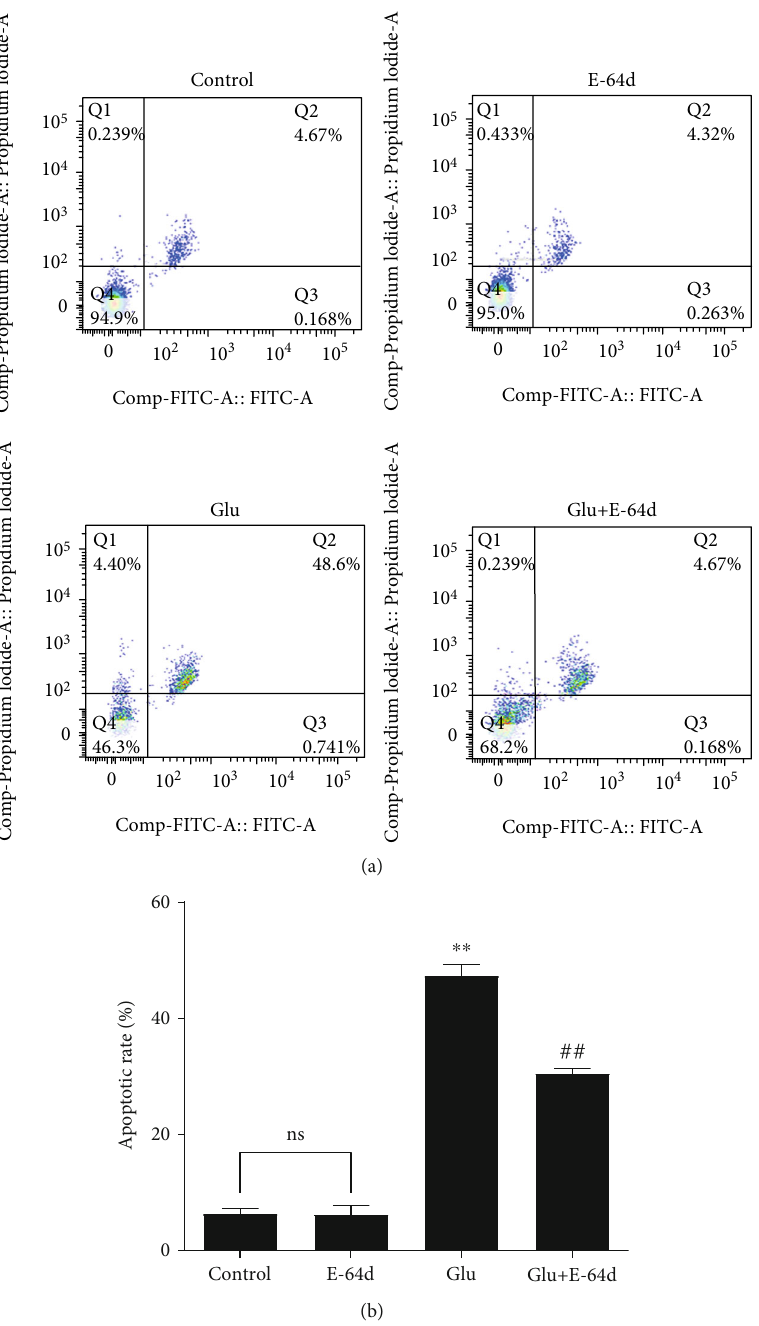
Figure 3: Apoptosis rates of glutamate-treated HT22 cells following 24 h of exposure to E-64d. (a) The cell apoptosis rate was measured via fl ow cytometry. (b) Quantitative analysis of the apoptosis rate in cells. Three independent experiments were performed, and the data are expressed as the mean ± SD . ∗∗ P < 0 : 01 vs. the Control group. ## P < 0 : 01 vs. the Glutamate group. n.s.: not signi fi